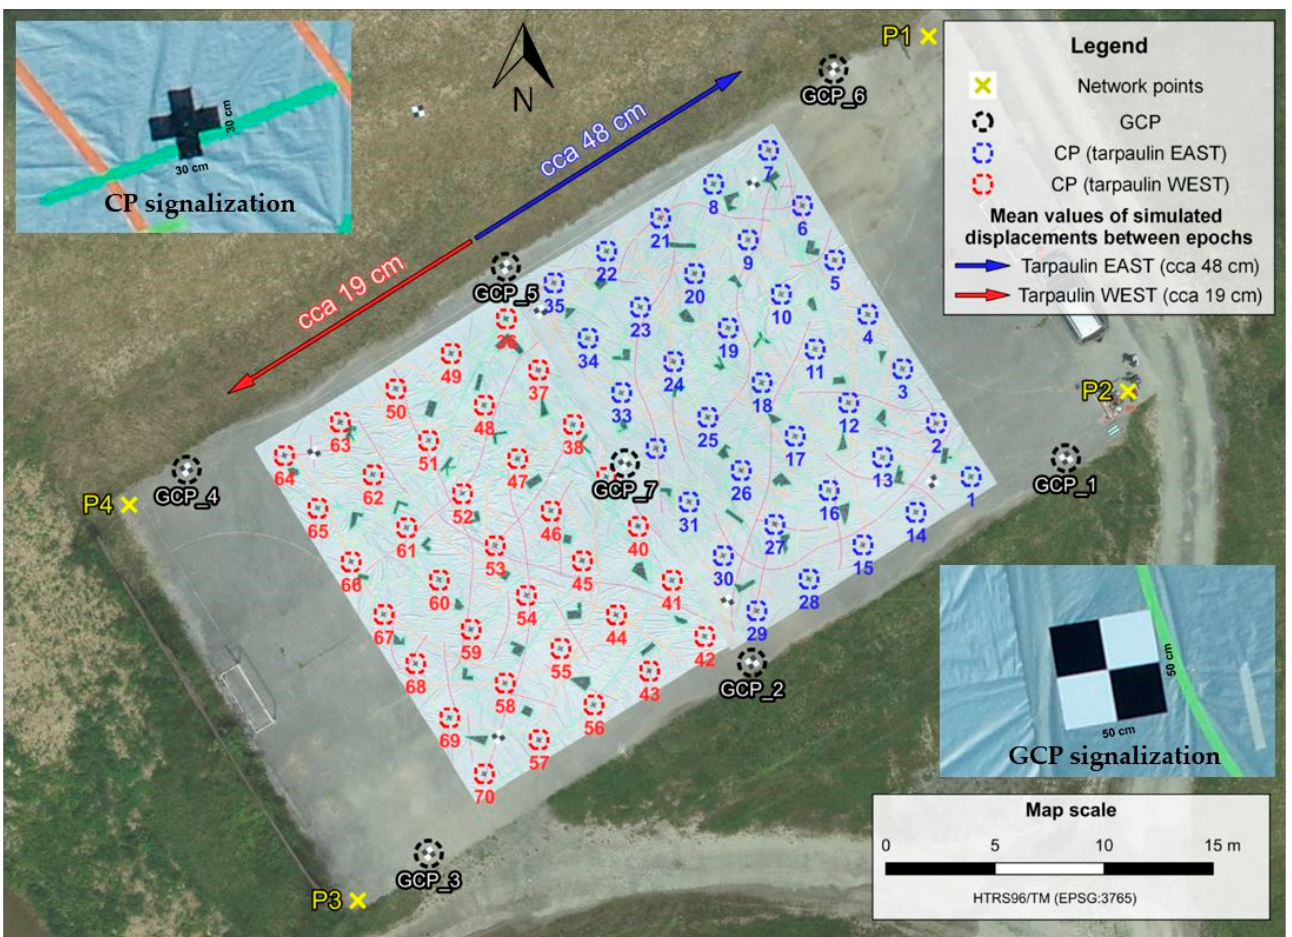
Figure 3. Presentation of the test field with mean tarpaulins displacements between epochs, and the distribution of network reference points, CPs, and GCPs.